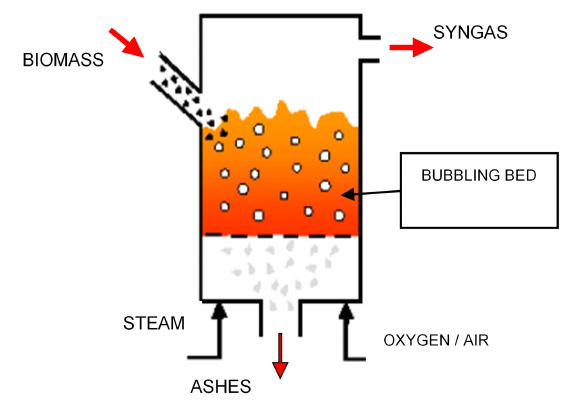
Figure 2. Bubbling fluidized-bed gasifier ([12], adapted by the author).